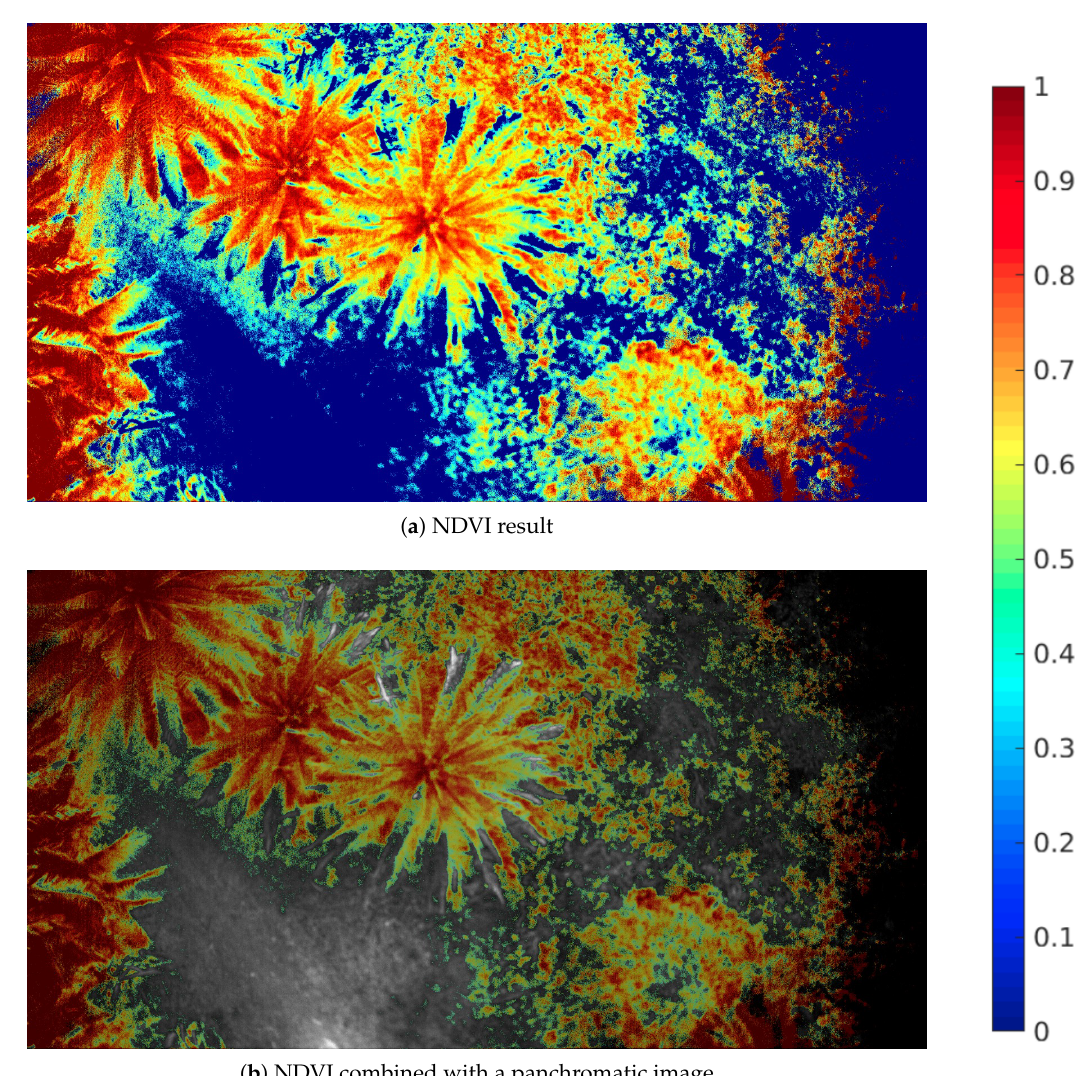
Figure 14. Results of one of the flights performed at the University campus, over a palm tree